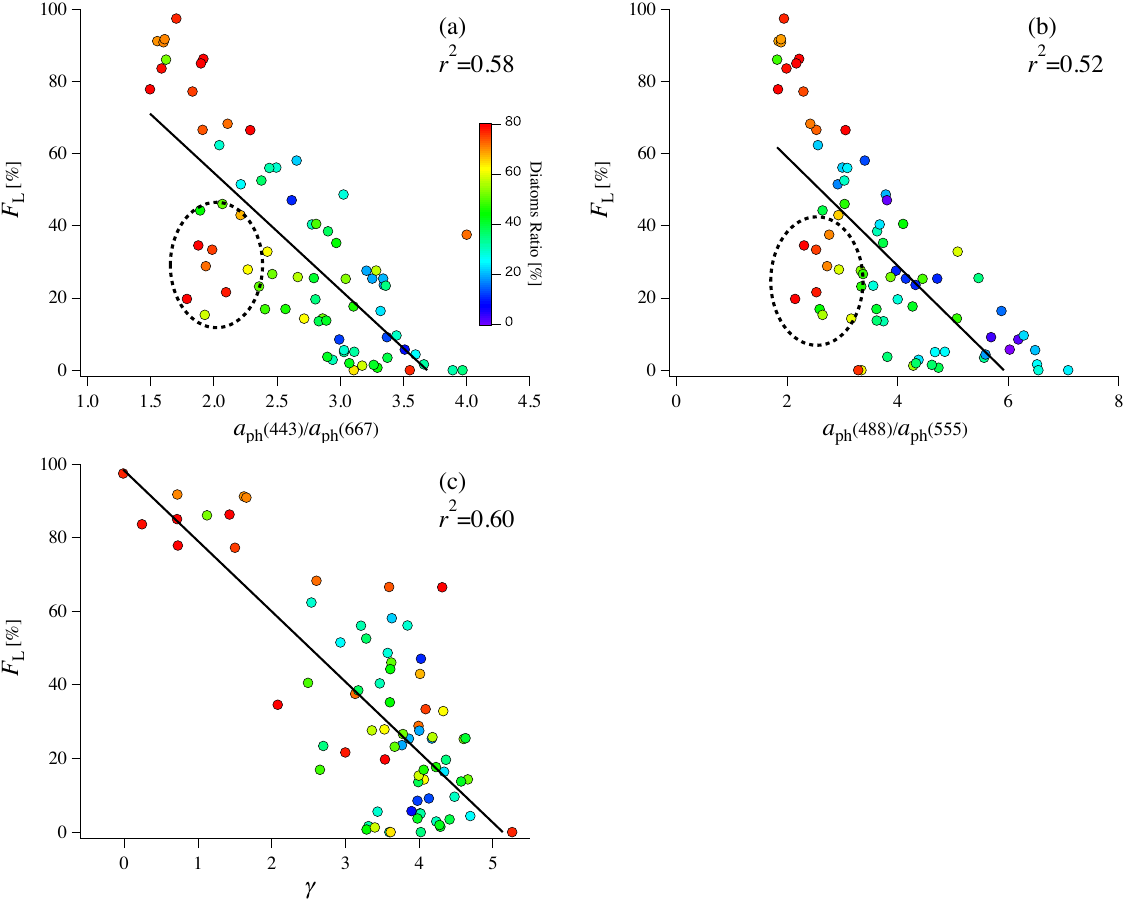
Fig. 2. Variation of in situ F L as a function of (a) in situ a ph (443)/ a ph (667), (b) in situ a ph (488)/ a ph (555) and (c) in situ γ . Colors in each plot correspond to diatom fraction calculated by HPLC pigment composition (Aiken et al., 2007). Dashed circles indicate samples whose diatom fraction is relatively high inpite of their relatively low F L values. Solid lines indicate regression lines and their slope and intercept values are descirbed in Table 3.